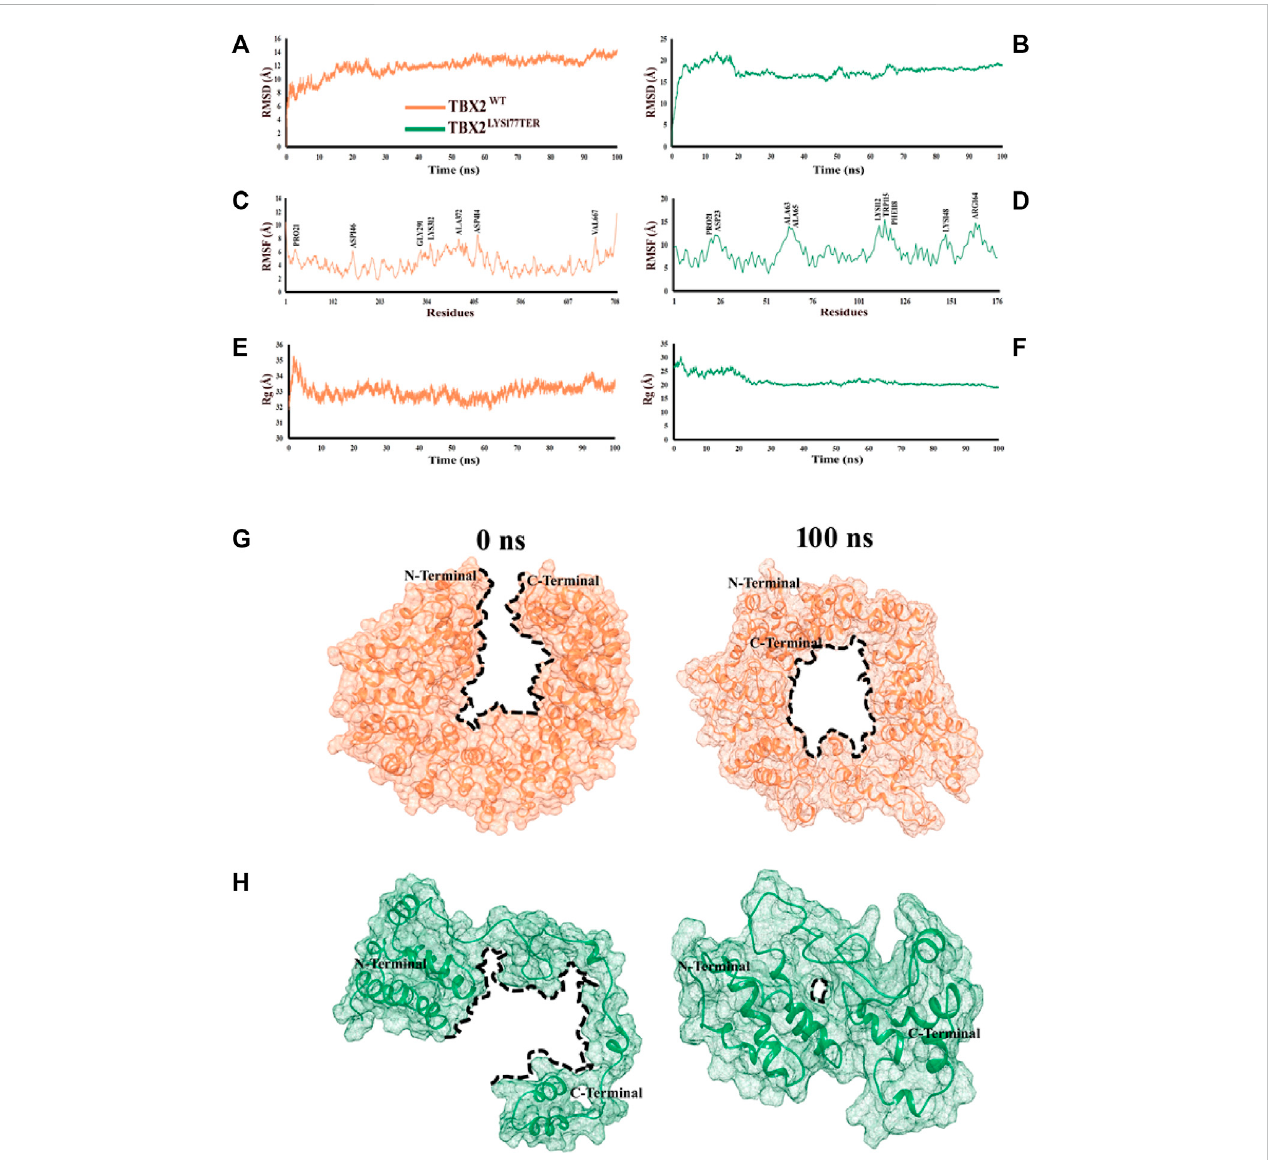
FIGURE 2 Time-dependent RMSD, RMSF, and Rg analyses of TBX2WT and TBX2LYS177TER over the 100 ns simulation time. (A, B) RMSD plot over the function of time. (C, D) RMSF plot over the function of time. (E, F) Radius of gyration plot over the function of time. TBX2 WT is depicted in coral, while TBX2 LYS177TER is depicted in sea green color. (G, H) Conformational changes in TBX2 WT and TBX2 LYS177TER over the 100 ns simulation time. (G) Conformational changes in TBX2 WT at 0 and 100 ns. (H) Conformational changes in TBX2 LYS177TER at 0 and 100 ns. TBX2 WT is depicted in coral, and TBX2 LYS177TER is depicted in sea green color. The black dotted lines signify the cavities. N- and C-terminals are depicted in black